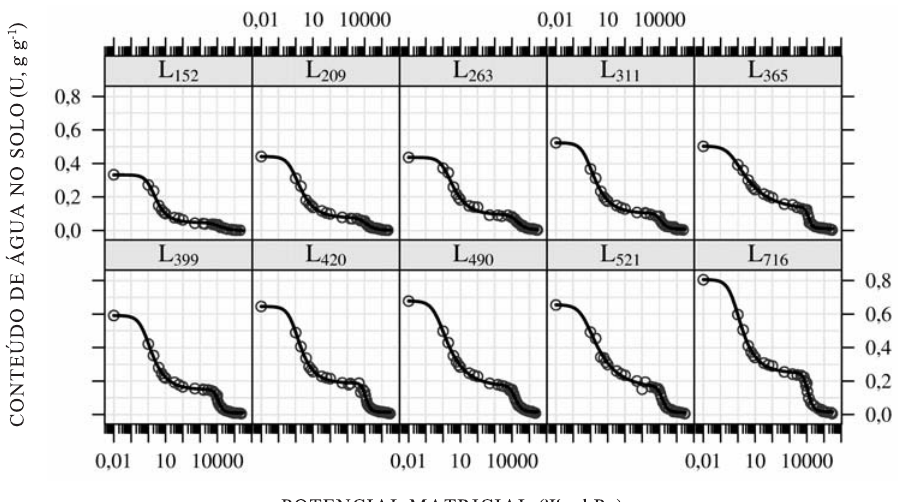
Figura 2. Curva de retenção de água [conteúdo de água no solo (U) em função do potencial matricial ( ΨΨΨΨΨ dos Latossolos oxídicos, segundo o modelo duplo van Genuchten. O número subscrito na legenda dos Latossolos (L) corresponde ao respectivo conteúdo de argila (g kg -1